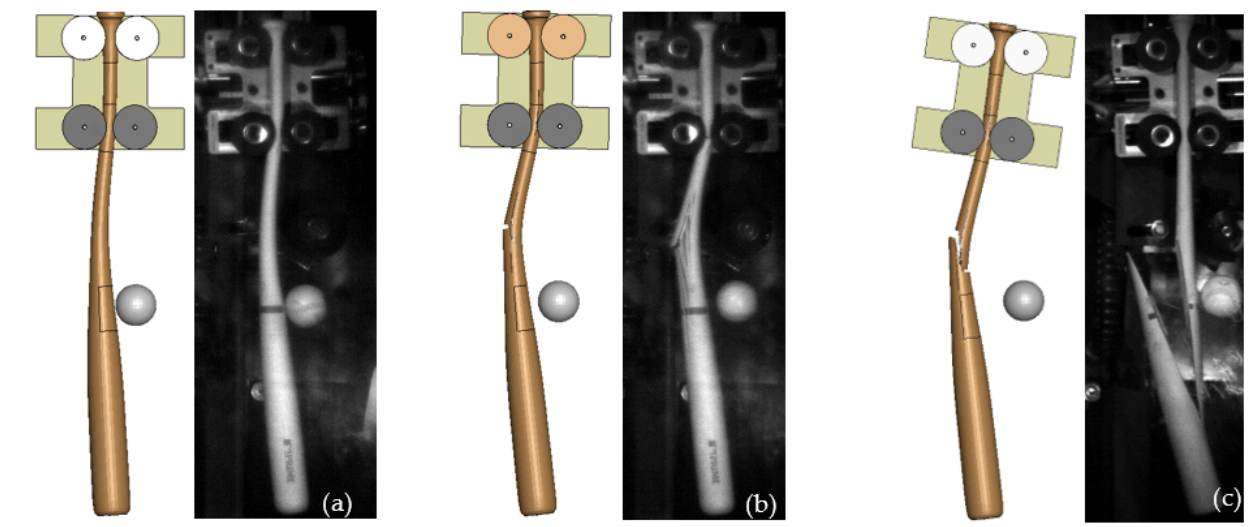
Figure 5. Finite element model outcomes compared to high-speed video images: ( a ) NF, ( b ) SPF, and ( c ) MPF.